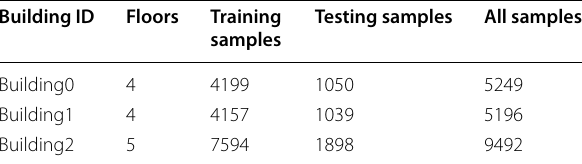
Table 2 The number of MAC repetitions between each building